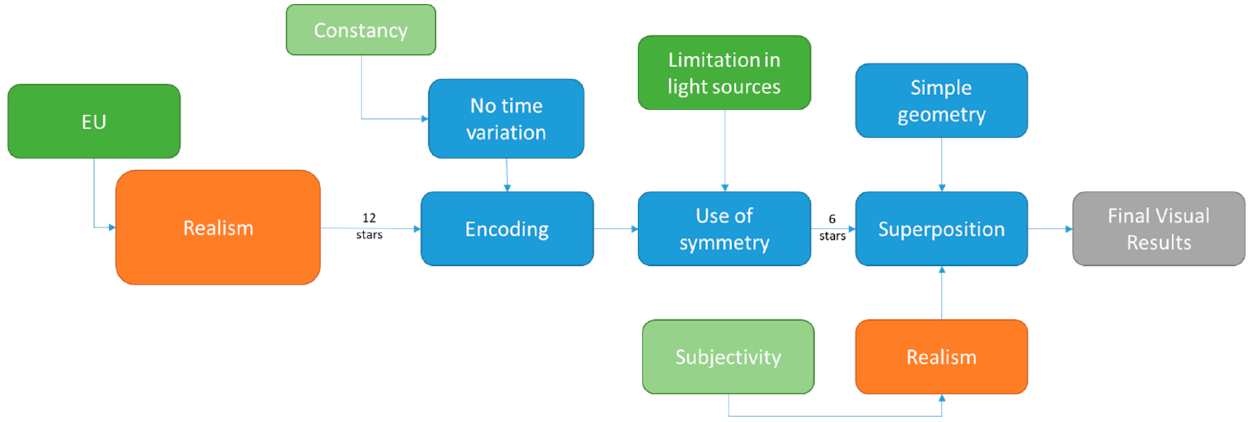
Figure 21. The working diagram for seasonal lighting of historical building façade (Tribute to EU). Designs 2021 , 5 , x FOR PEER REVIEW